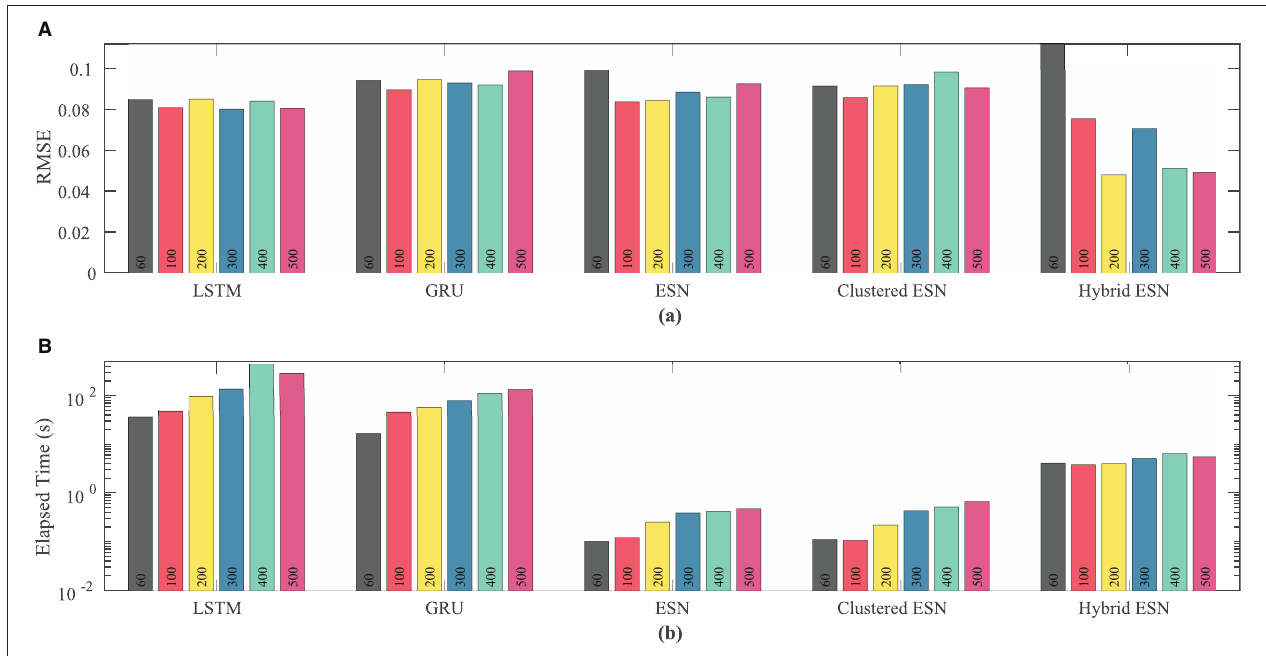
FIGURE 12 | Comparison of RMSE (A) and computational time (B) for each method and network size tested for the experimental